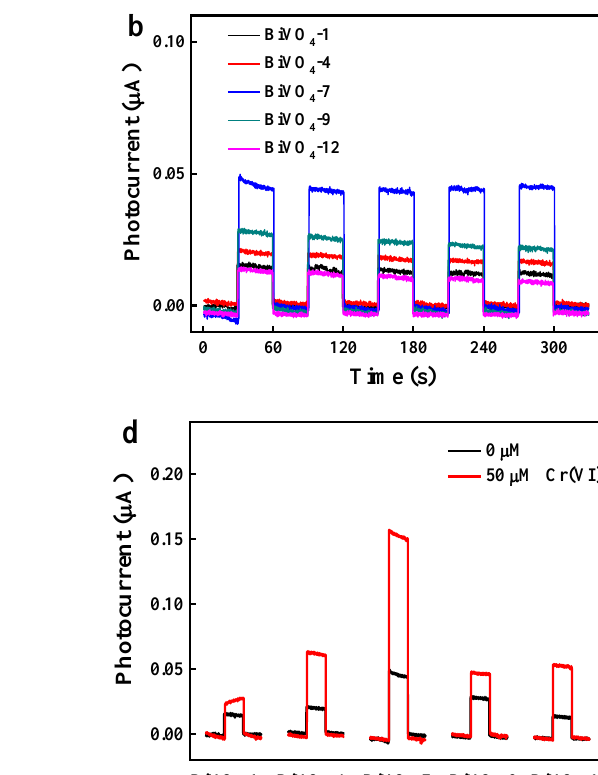
maximum photocurrent change and therefore, the highest photoelectric performance for detecting Cr(VI).